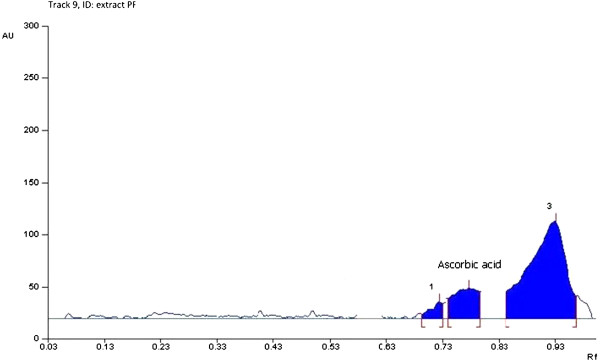
High performance thin liquid chromatography profiles of 
Paederia foetida 
extract.